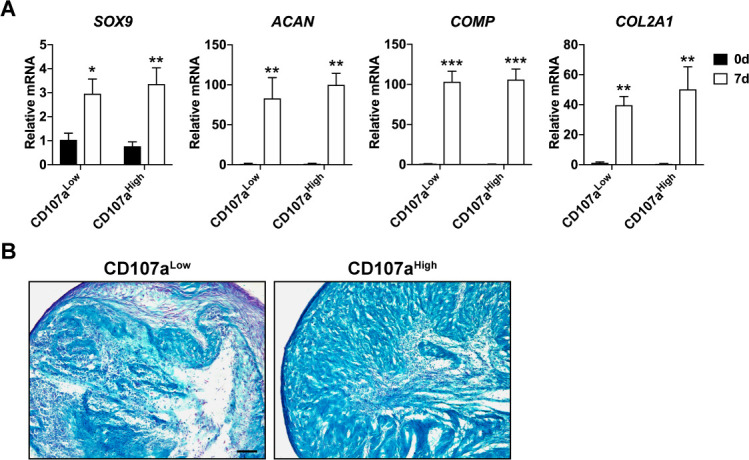
Chondrogenic differentiation among human CD107alow and CD107ahigh cells.(A) Chondrogenic gene expression among human CD107alow and CD107ahigh mesenchymal cells, including SRY-Box transcription factor 9 (SOX9), Aggrecan (ACAN), Cartilage oligomeric matrix protein (COMP), and Collagen type 2 A1 (COL2A1), assessed by qRT-PCR at 0 and 7 d of differentiation. (B) Chondrogenic differentiation, as assessed by alcian blue staining at 28 d of differentiation in high-density micromass culture. Black scale bar: 100 μm. *p<0.05; **p<0.01; ***p<0.001 in relation to corresponding 0 d sample. Statistical analysis was performed using a two-way ANOVA followed by Sidak’s multiple comparisons test. Data repeated in experimental triplicates.